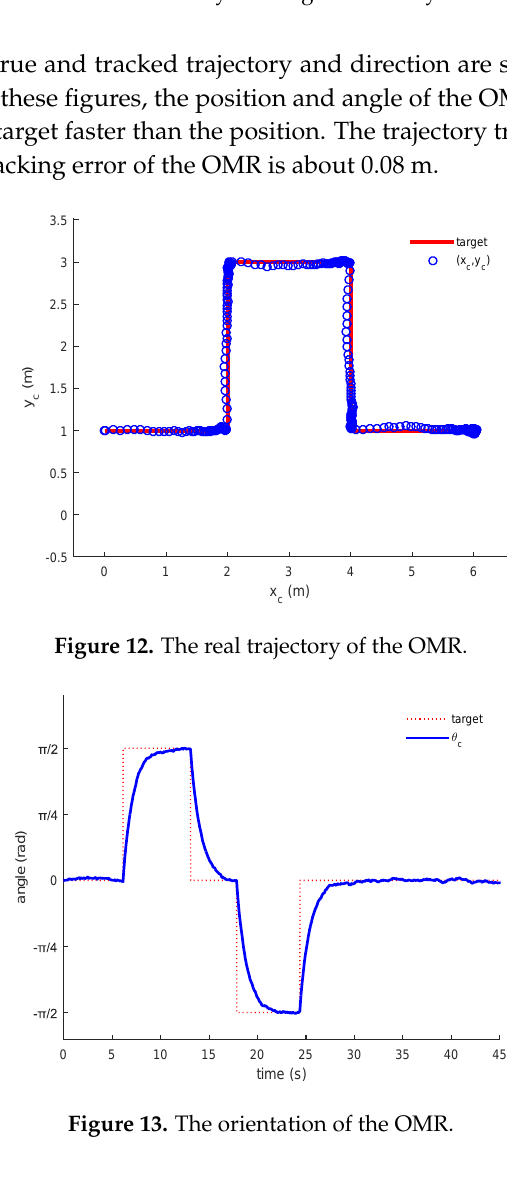
Figure 11. The line velocity and angular velocity of the OMR.